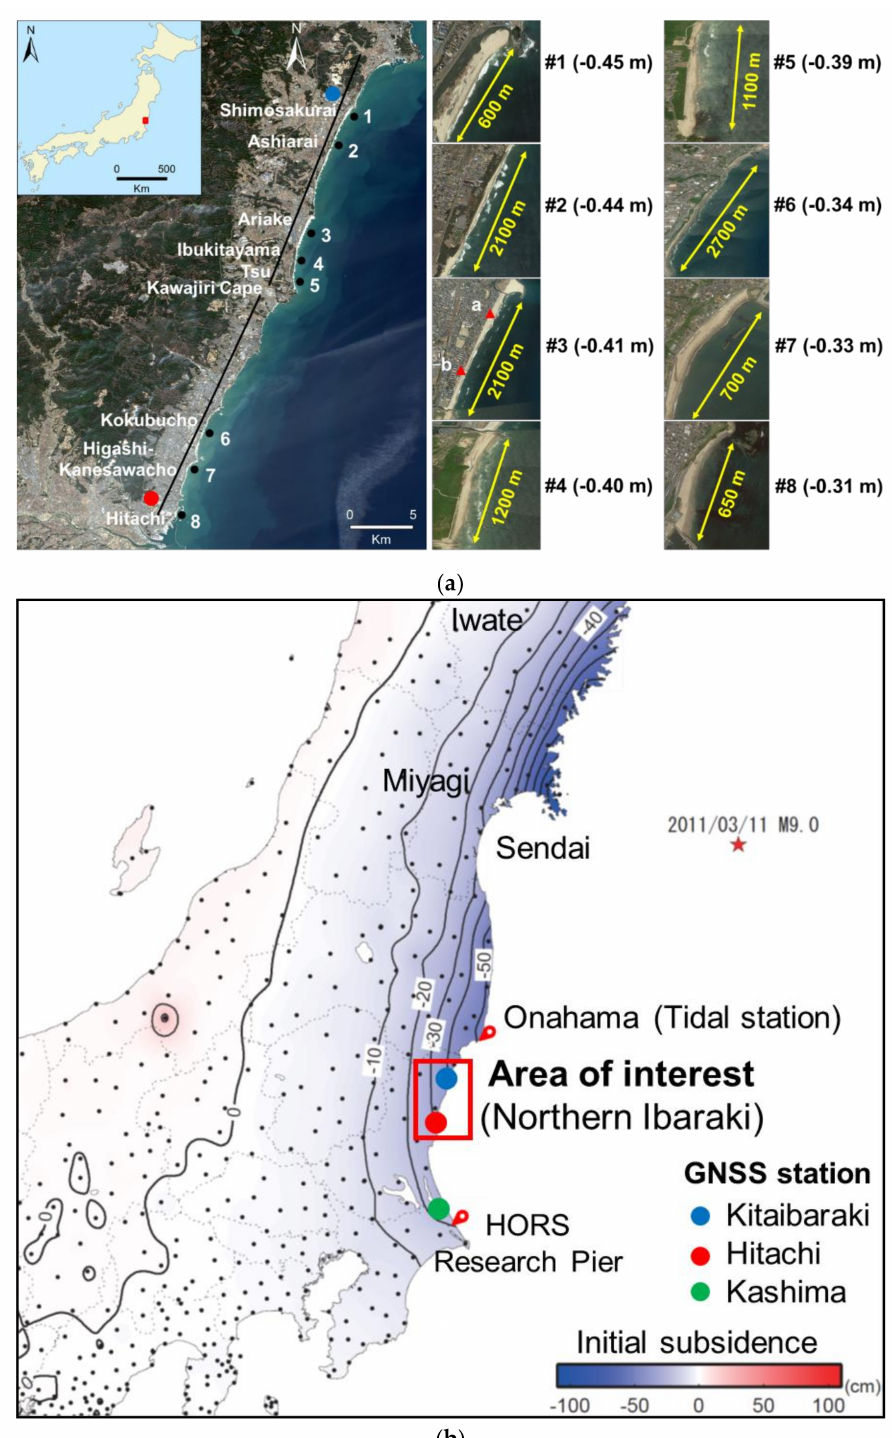
Figure 1. ( a ) Locations of the study area (left panel) and eight sandy beaches: #1 Shimosakurai, #2 Ashiarai, #3 Ariake, #4 Ibukitayama, #5 Tsu, #6 Kokubucho, #7 Higashi-Kanesawacho, and #8 Hitachi, with the amount of subsidence due to the earthquake (right panel). The black line behind the coast represents the baselines (left panel). Red triangles shown in the panel of Ariake (#3) represent locations of beach profile surveys. Detached breakwaters have been implemented in the Ariake, Tsu, and Higashi-Kanesawacho. ( b ) Crustal deformation after the Great East Japan Earthquake (M9.0); GNSS observation stations at Kitaibaraki, Hitachi, and Kashima by Geospatial Information Authority of Japan (GSI) (blue, red, and green points, respectively). The contour lines represent the amount of initial subsidence caused by the earthquake (unit: cm). The red star represents the earthquake